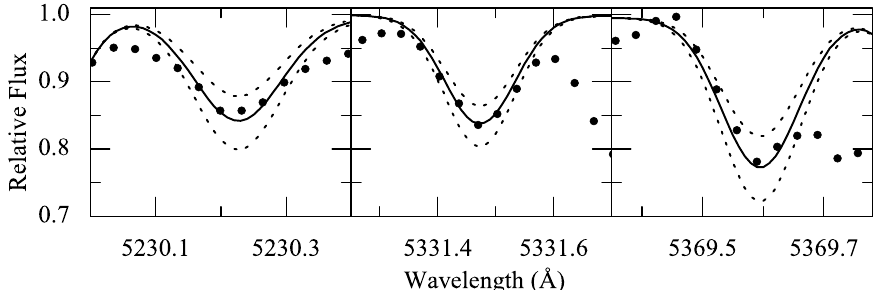
Fig. 15. Three Co I lines in the spectrum of HD 209621. The synthetic profiles are given for the cobalt abundance log ϵ (Co) = 3 . 23 ± 0 . 15. obtained from KLL. Spectral synthesis of the line at 6216.4 ˚A supports slightly lower abundance of vanadium, log ϵ (V) = 2 . 17 or [V/Fe] = –0.20. The abundance of chromium abundance calculated using the lines of neutral an ionized